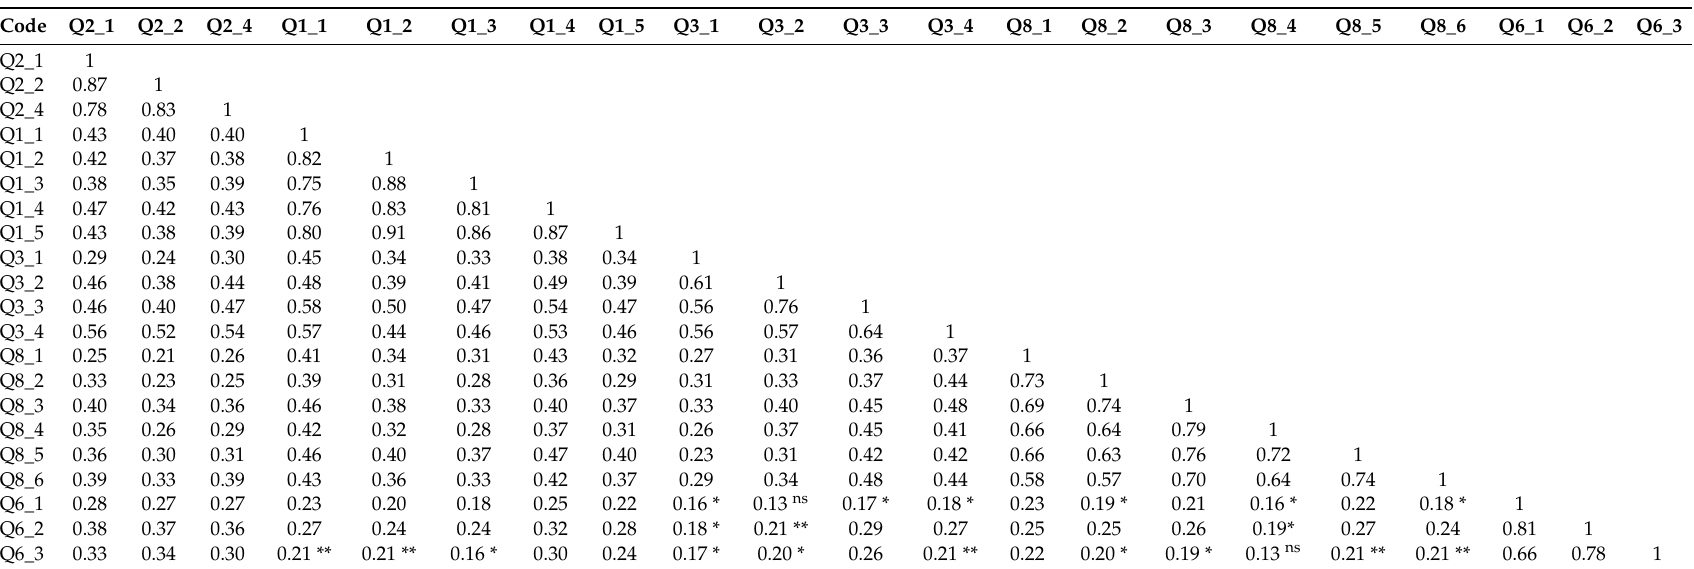
Table A3. Correlation of Measures for